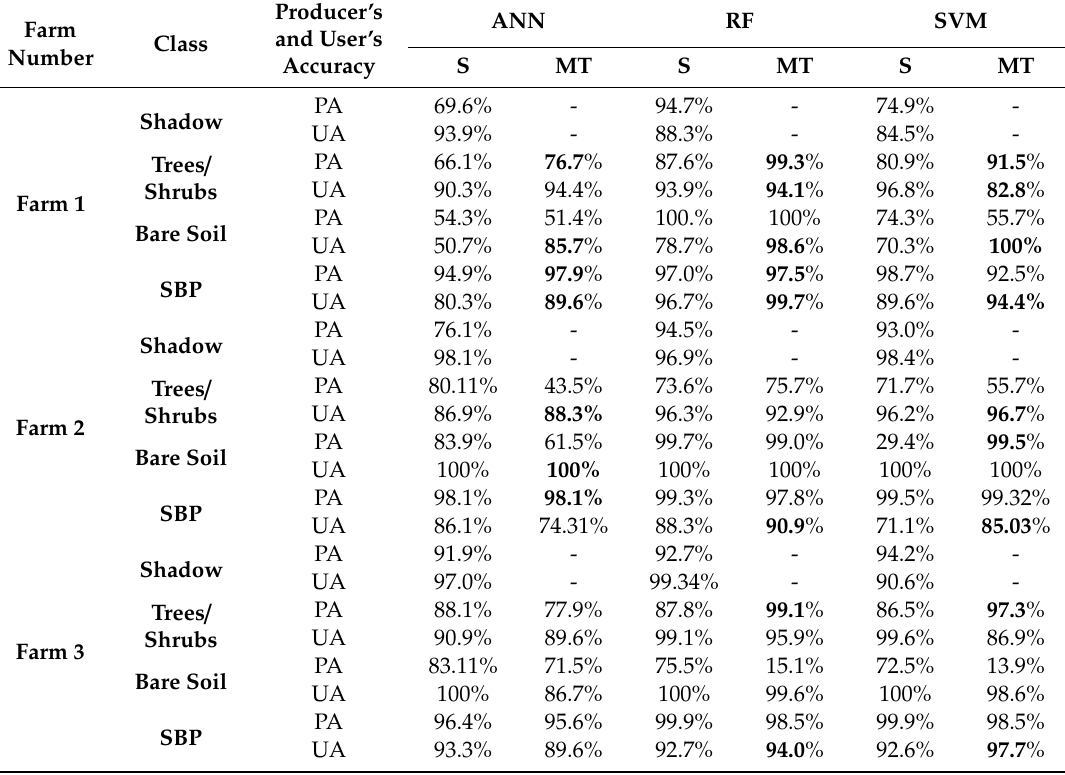
Table 5. Producer´s and user´s accuracy of single epoch (S) and multitemporal (MT) classifications returned by Artificial Neural Networks (ANN), Random Forest (RF) and Support Vector Machine (SVM) algorithms. SBP – Sown Biodiverse